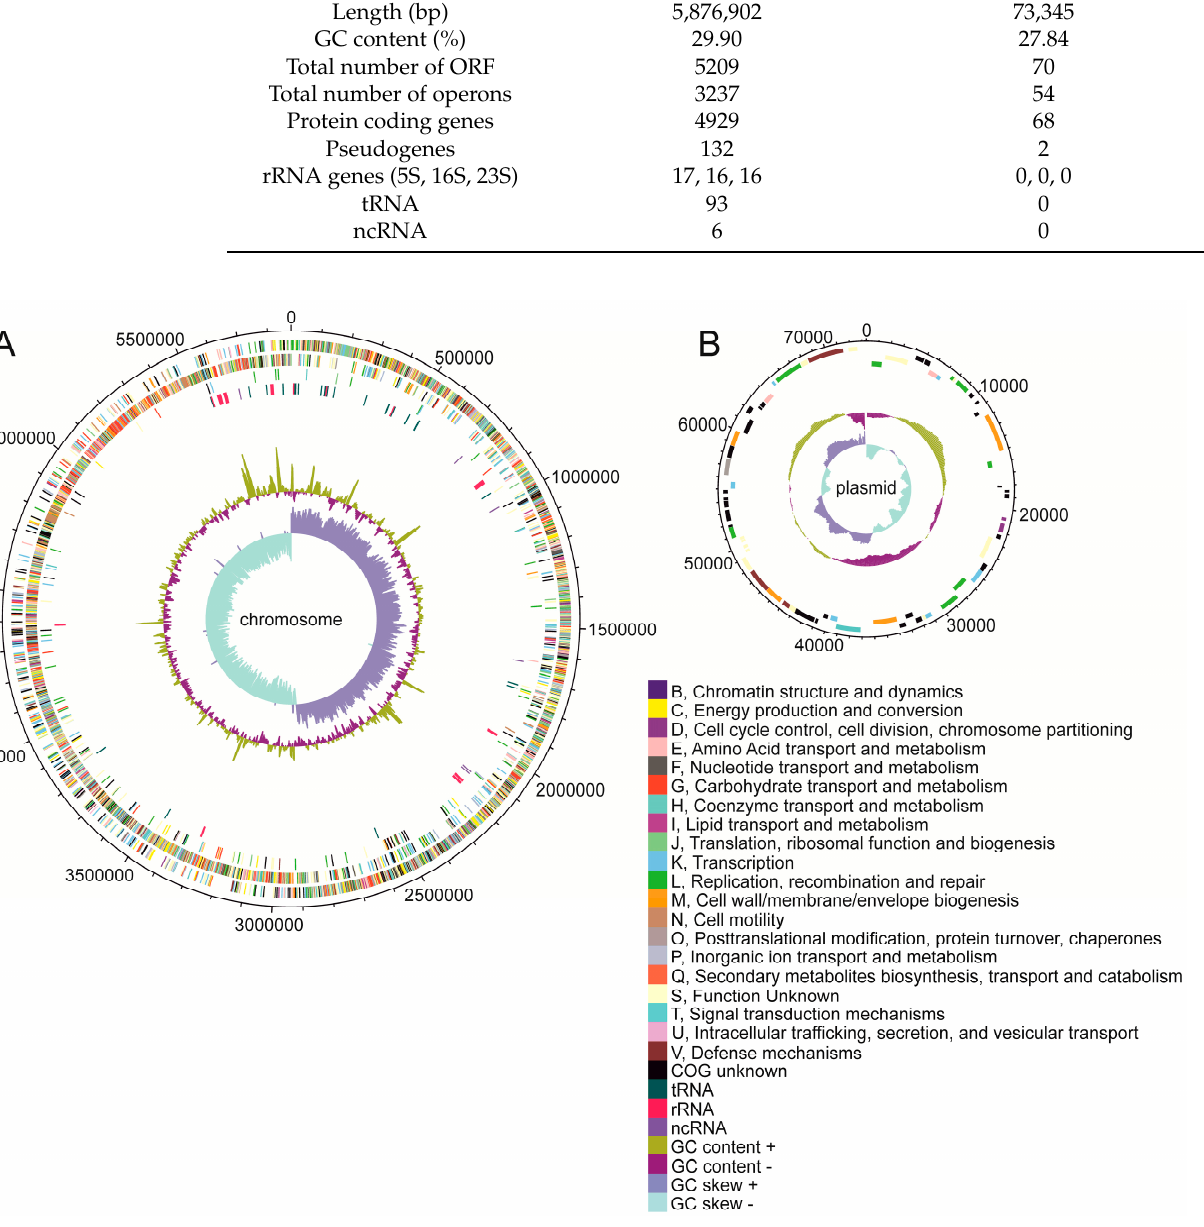
Figure 1. Circular maps of C. beijerinckii DSM 791 ( A ) chromosome and ( B ) plasmid. The outermost and the second outermost circles represent CDSs on the forward and reverse strands, respectively. The third circle represents pseudogenes, and the colors represent the COG functional classification. The fourth circle represents RNA genes, while the colors distinguish between tRNA, rRNA, and ncRNA. The inner shaded area represents (from outside in) GC content and GC skew, plotted using a 10-kb window with a step of 200 bp while the colors distinguish between above and below average values.